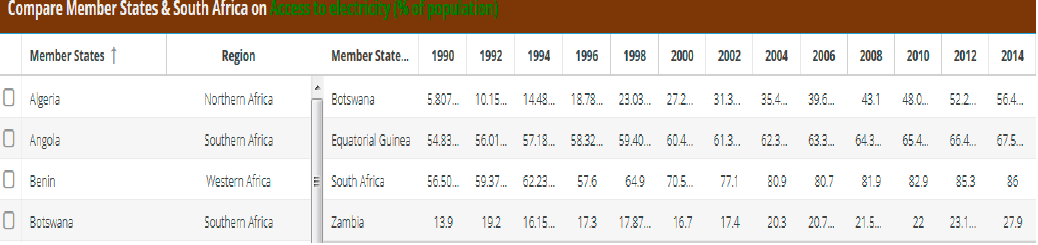
Figure 11. Data comparison for four countries. Access to electricity comparison.